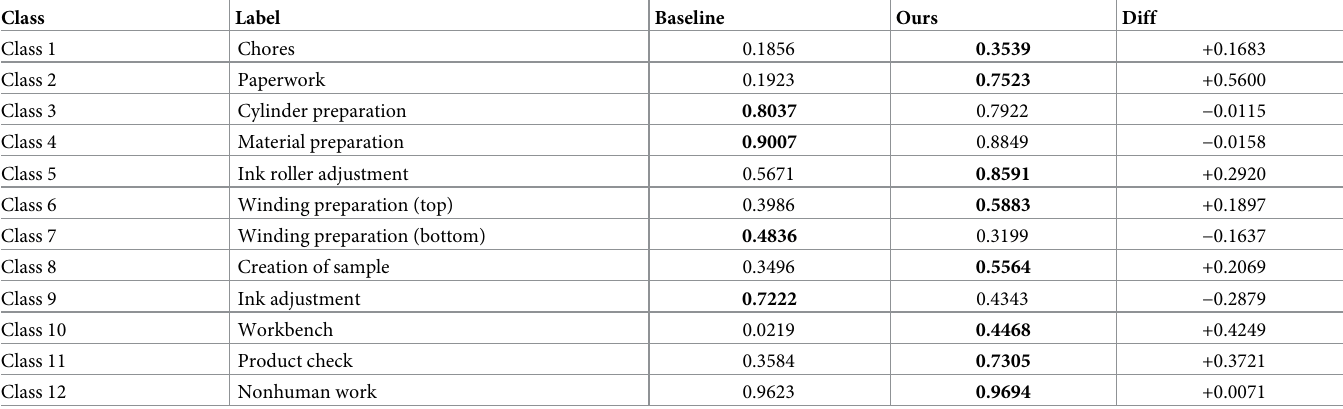
Table 8. Comparison of label-by-label precision between the two LSTM-CNN models (test set). The highest scores are expressed in a bold